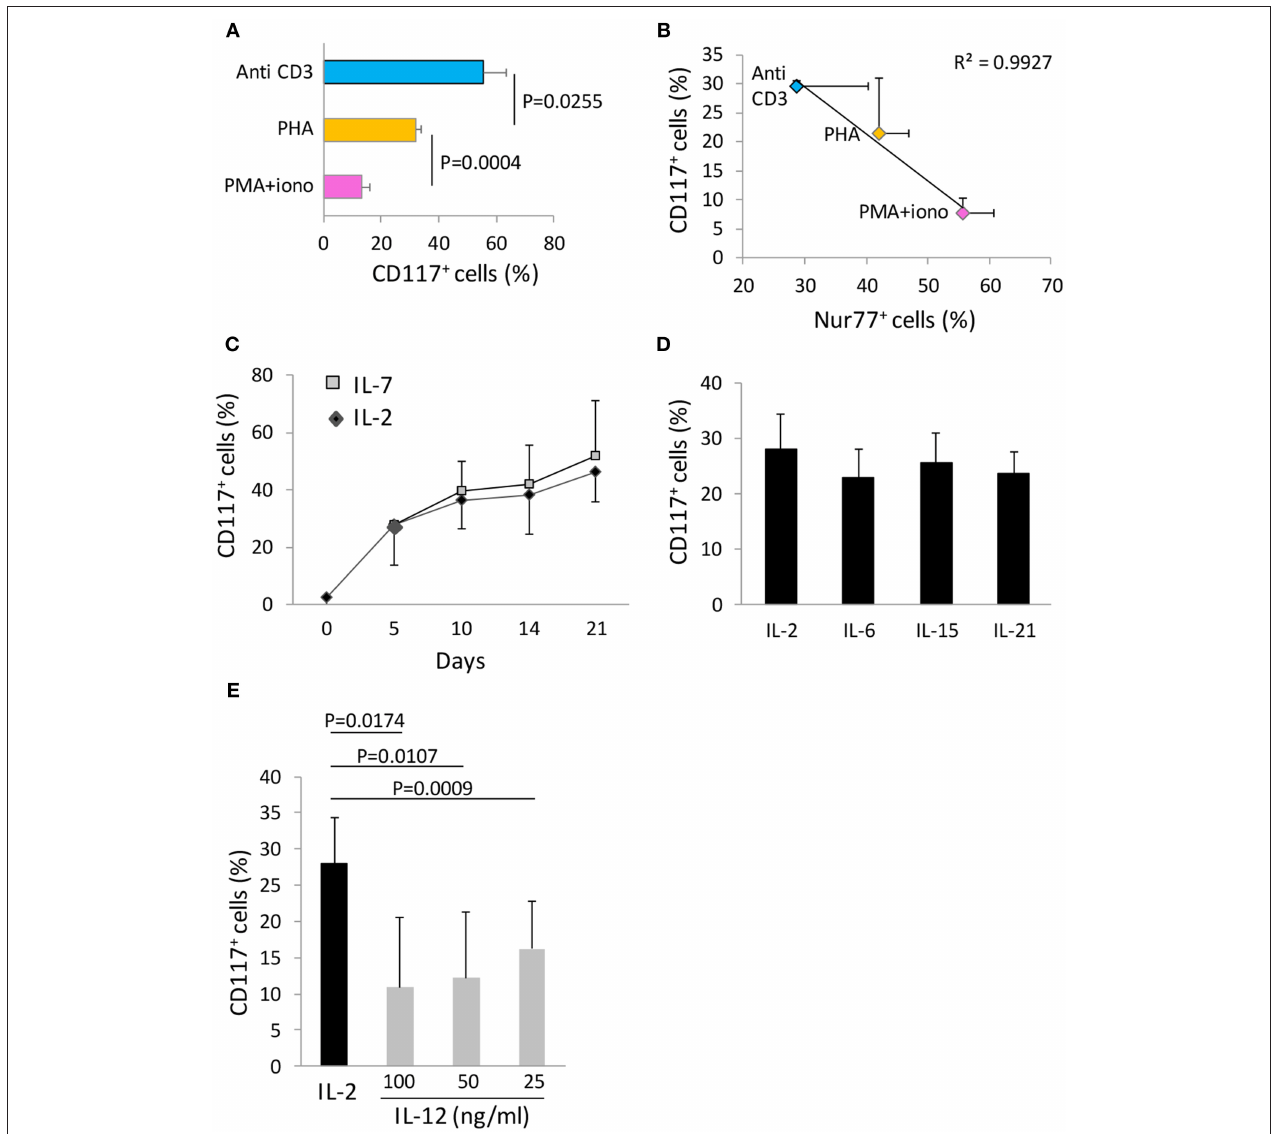
FIGURE 4 | CD117 expression depends on cytokine milieu and the strength of the activating stimulus. (A) CBMC were activated with the indicated stimuli and the percentage of CD8 + T cells expressing CD117 was recorded at day 21. Data are from three independent samples. (B) CBMC were activated with the indicated stimuli and the percentage of CD8 + T cells expressing Nur77 at day 1 was plotted against the percentage of CD8 + T cells expressing CD117 at day 4. Data are from four independent samples. (C) Activated CBMC at day 5 were either maintained in IL-2 50 U/mL, or washed and maintained in IL-7 50ng/mL. The percentage of CD8 + T cells expressing CD117 was recorded at the indicated time points. Data are from three independent samples. (D) Activated CBMC at day 5 were either maintained in IL-2 50 U/mL, or washed and maintained in IL-6, IL-15, or IL-21, each at the concentration of 50ng/mL. The percentage of CD8 + T cells expressing CD117 at day 10 is shown. Data are from three independent samples. (E) Activated CBMC at day 5 were either maintained in IL-2 50 U/mL, or washed and maintained in IL-12 at the concentrations indicated. The percentage of CD8 + T cells expressing CD117 was recorded at day 10. Data are from three independent samples.